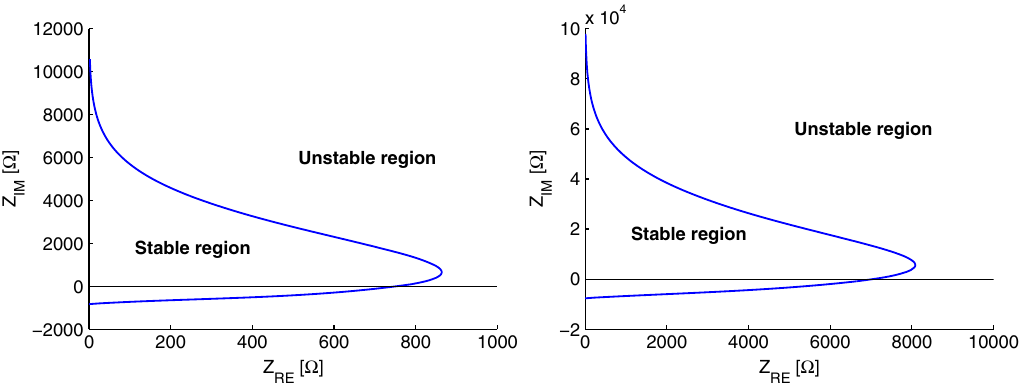
FIG. 5. Threshold curves of the stability diagram of the real and imaginary part of the impedance for the longitudinal dipolar oscillations m ¼ 1 , with the resonant mode frequency at ω and 0.21 rad